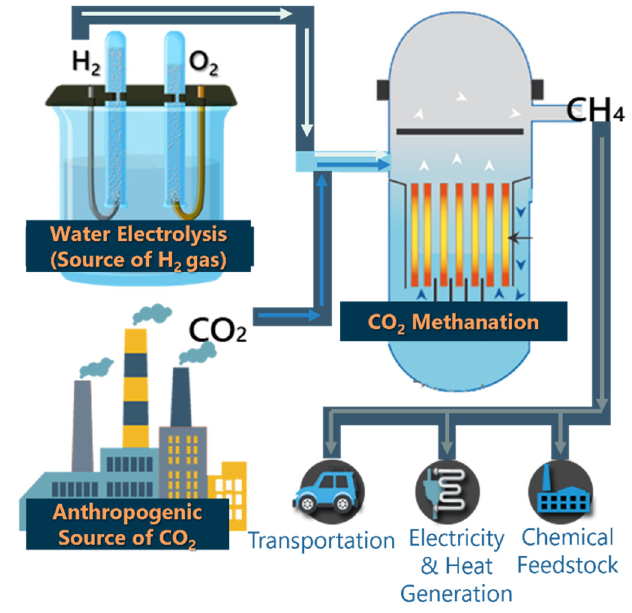
Figure 1. Power-to-gas technology.